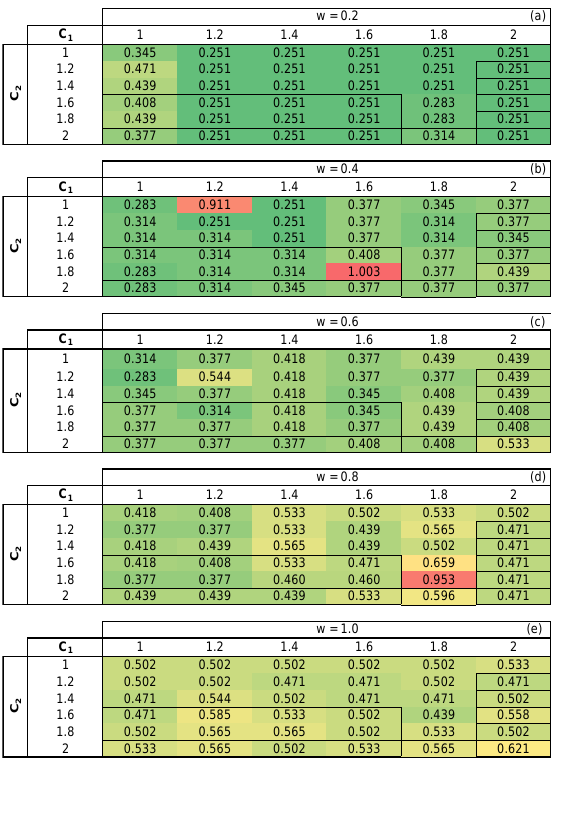
Table 7. Average convergence time in seconds for nine